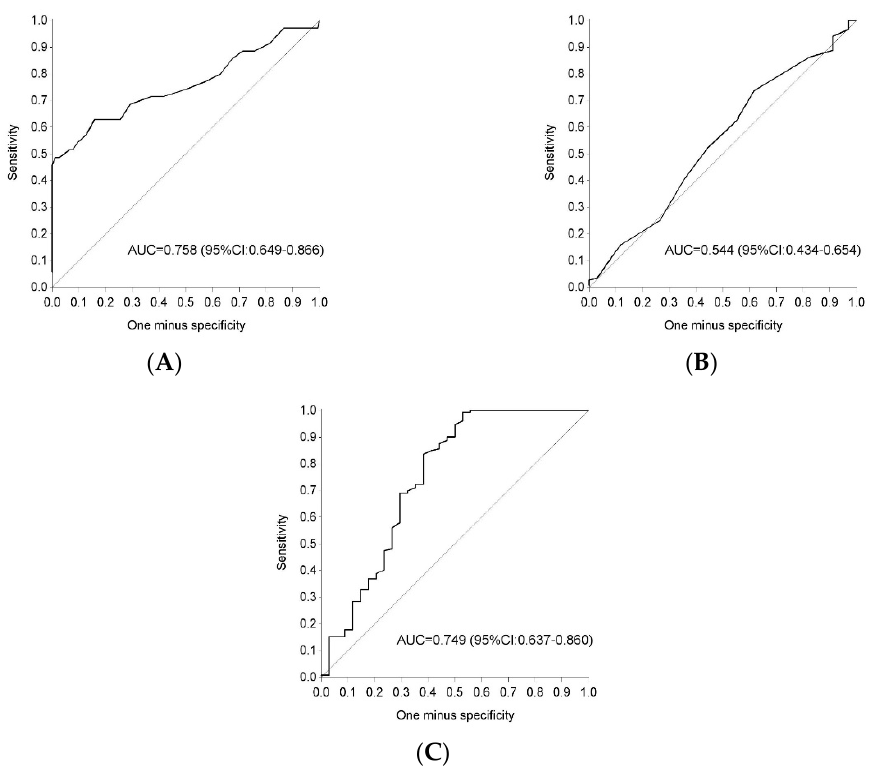
Figure 2. ROC curve for fasting plasma glucose and HbA1c postpartum as a predictor for glucose intolerance. ROC: receiver operating curve; AUC: area under the curve; ( A ) ROC curve for fasting plasma glucose alone; ( B ) ROC curve for HbA1c alone; ( C ) ROC curve for fasting plasma glucose and HbA1c